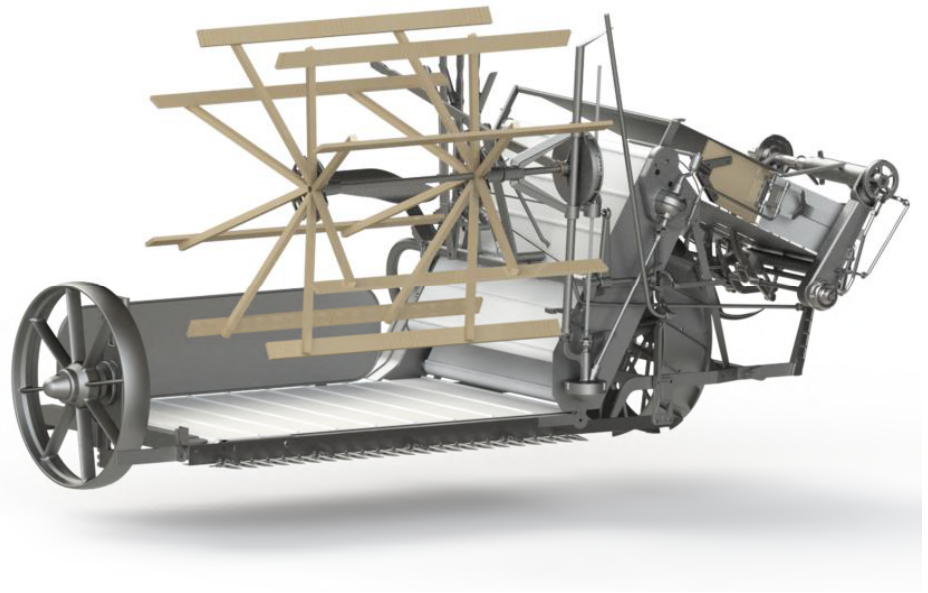
Figure 33. Front view of the final assembly.